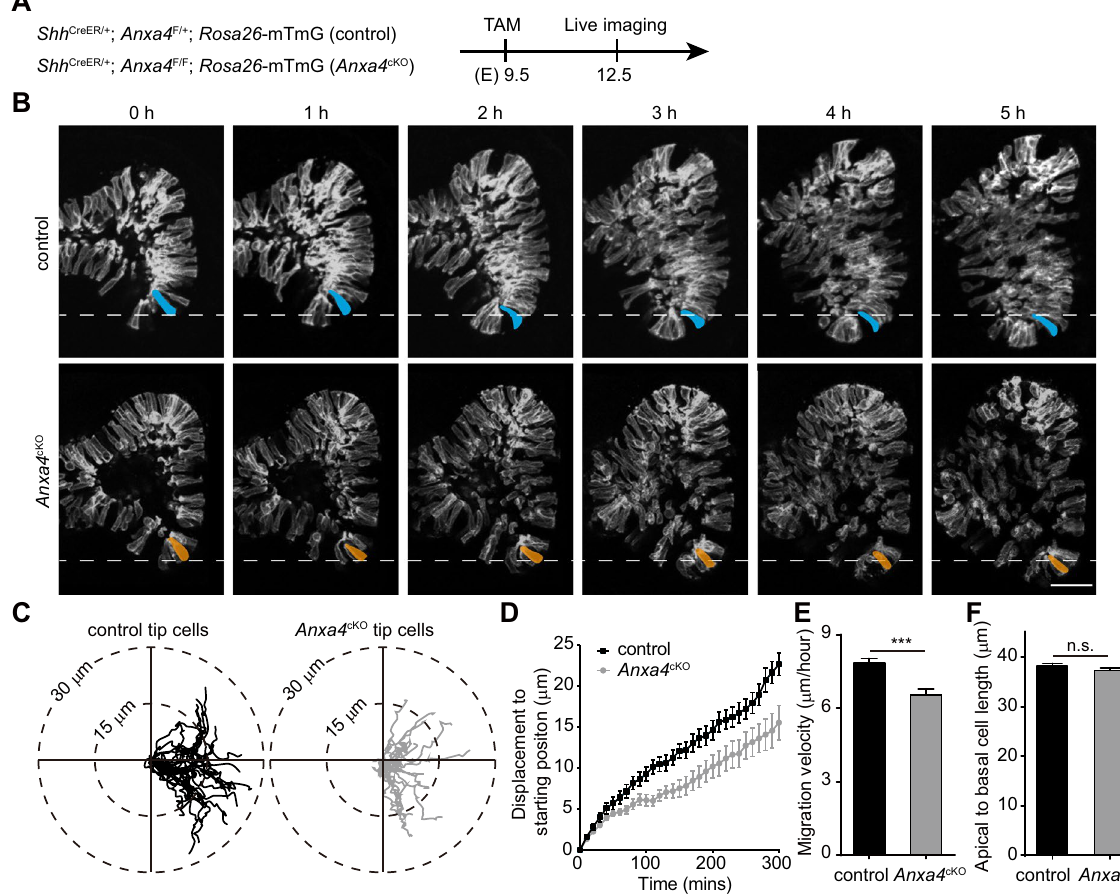
Figure 3. Anxa4 promotes airway epithelial progenitor cell migration. ( A ) Pregnant females carrying Shh CreER/ + ; Anxa4 F/ + ; Rosa26 -mTmG (control) and Shh CreER/ + ; Anxa4 F/F ; Rosa26 -mTmG ( Anxa4 cKO ) embryos were treated with tamoxifen (TAM) at E9.5 and lungs were imaged at E12.5. ( B ) Representative images of mosaic labeled control and Anxa4 cKO airway bud formation. One tip cells in control and Anxa4 cKO RCd.L1 buds are highlighted by blue and orange, respectively. Scale bar: 50 μ m. ( C – F ) Cell track plots of tip cells in control lung (25 cells) and Anxa4 cKO lungs (16 cells) after aligning their starting positions ( C ), showing that Anxa4 cKO tip cells had shorter migration tracks and migration displacement than that of control tip cells ( C , D ); The migration velocity analysis showed that the migration velocity of Anxa4 cKO cells was decreased significantly ( E ) and the apical-to-basal cell length of Anxa4 cKO cells was similar to that of control cells ( F ). Data are presented as mean ± SEM; n = 3 samples per genotype; n.s., not significant; *** p < 0.001; Student’s t